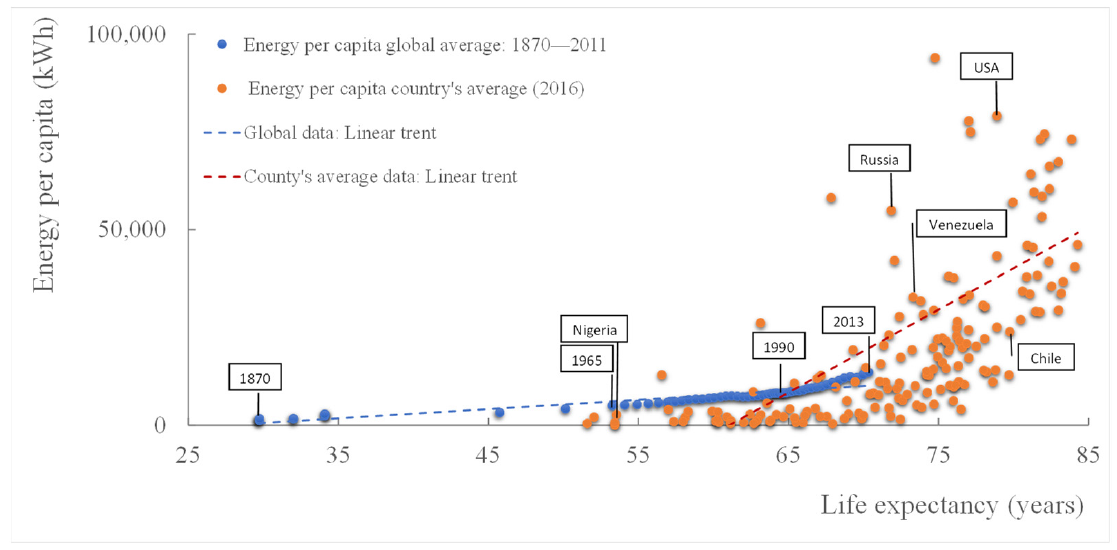
Figure 3. Life expectancy related to annual energy consumption per capita; global average (1965–2011) and 172 counties’ average data (2016) [6,18].